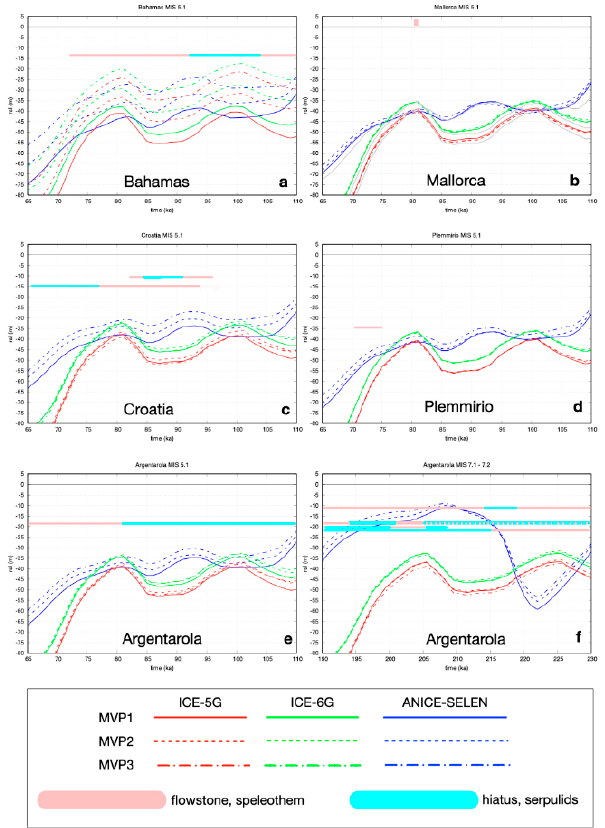
Figure 8. Predicted RSL curves for ICE-5G (red curves), ICE-6G (green curves), and ANICE-SELEN (blue curves) ice sheet models, in combination with mantle viscosity profiles (MVP) 1–3 (solid, dashed, and dotted, respectively) at each site and with respect to the measured elevations. ( a ) predicted RSL curves at MIS 5.1 in the Bahamas and with respect to the elevation of the flowstone. ( b ) predicted RSL curves at MIS 5.1 in Mallorca. ( c ) predicted RSL curves at MIS 5.1 in Croatia and elevation of the speleothems. ( d ) predicted RSL curves at MIS 5.1 at Plemmirio and elevation of the speleothem. ( e ) predicted RSL curves at MIS 5.1 at Argentarola and elevation of the speleothems. ( f ) predicted RSL curves at MIS 7.1–7.2 at Argentarola and elevation of the speleothems.